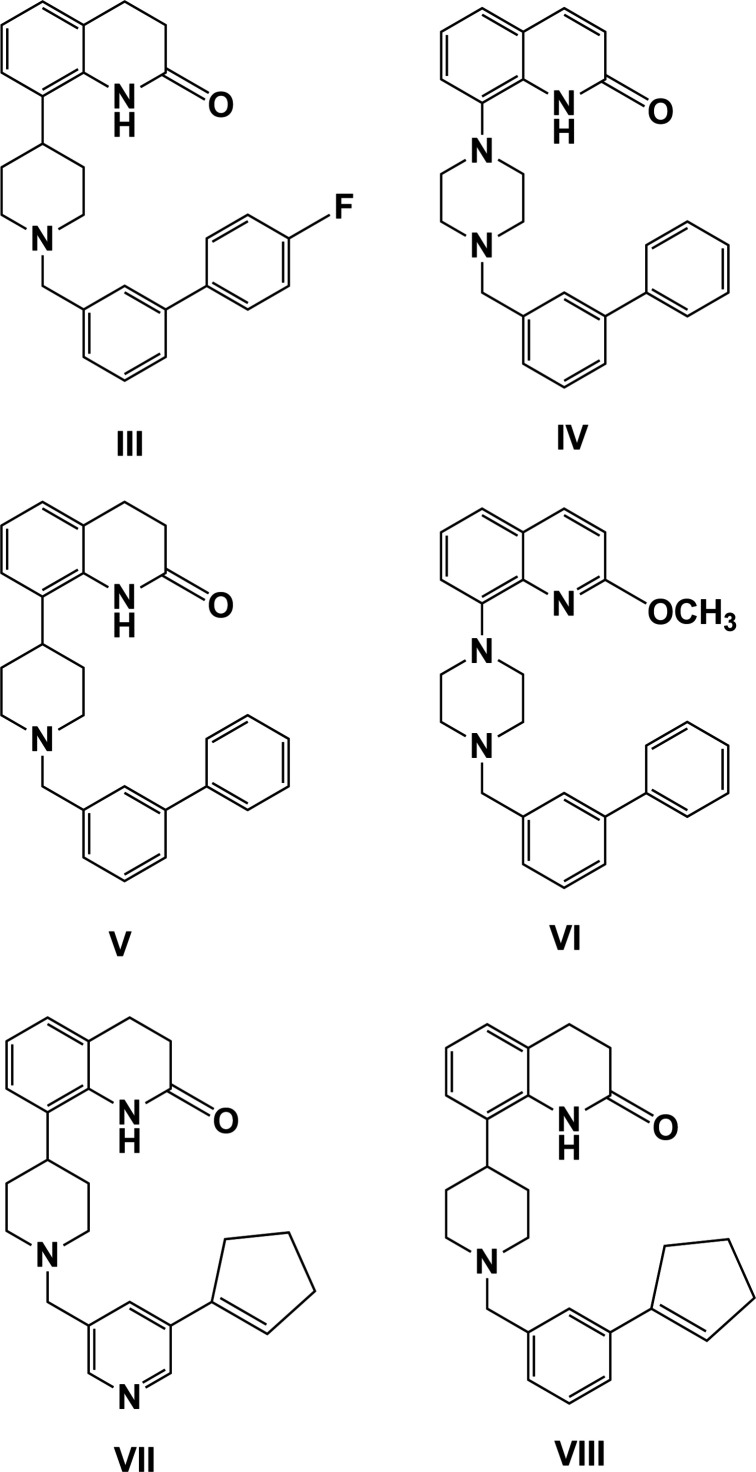
Chemical diagrams of similar compounds deposited with the CSD (Groom et al., 2016 ▸); see § 5 Database survey.